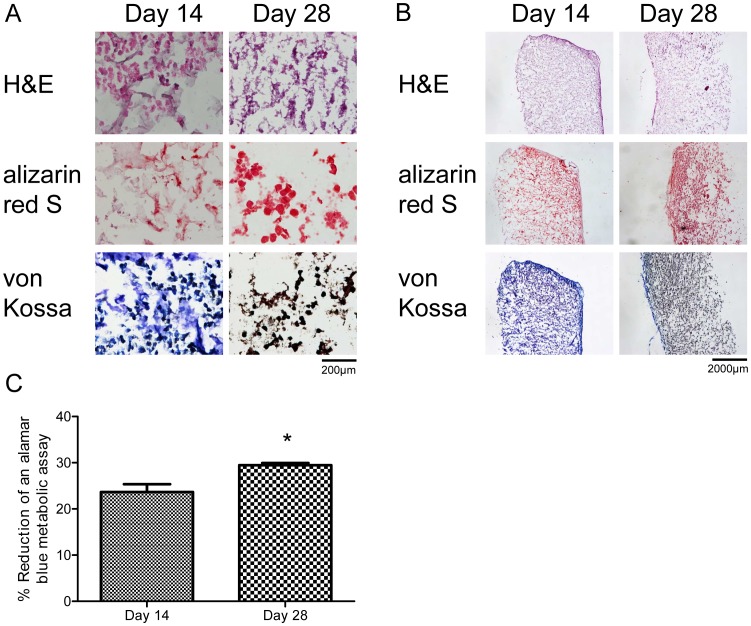
Assessing mineralization of 4T1 cells grown in an osteogenic cocktail within 3D collagen scaffolds.Representative images are shown at 400× and 40× magnifications and the scale bars represent 200 µm and 2000 µm respectively. (A) Positive hematoxylin and eosin (H&E) staining was observed at 400× magnification by day 14 and the intensity of the hematoxylin stain increased by day 28. Some positive alizarin red S staining for calcium (red) was detected by day 14. Complete positive staining with alizarin red S and von Kossa (including toluidine blue counterstain) was observed by day 28. (B) At 40× magnification the previously described patterns of staining are confirmed and minor contraction and disintegration of the scaffolds are observed over time. (C) Assessing cell viability of 4T1 cells grown within the 3D scaffolds using an alamar blue metabolic assay. An increase in cell viability was detected between day 14 and day 28. Each time point represent the mean % reduction in alamar blue +/− SEM, n = 3, students t-test. *P = 0.0284 day 28 vs. day 14. OC (osteogenic cocktail) = with 50 µg/ml ascorbic acid and 10 mM β-glycerophosphate.